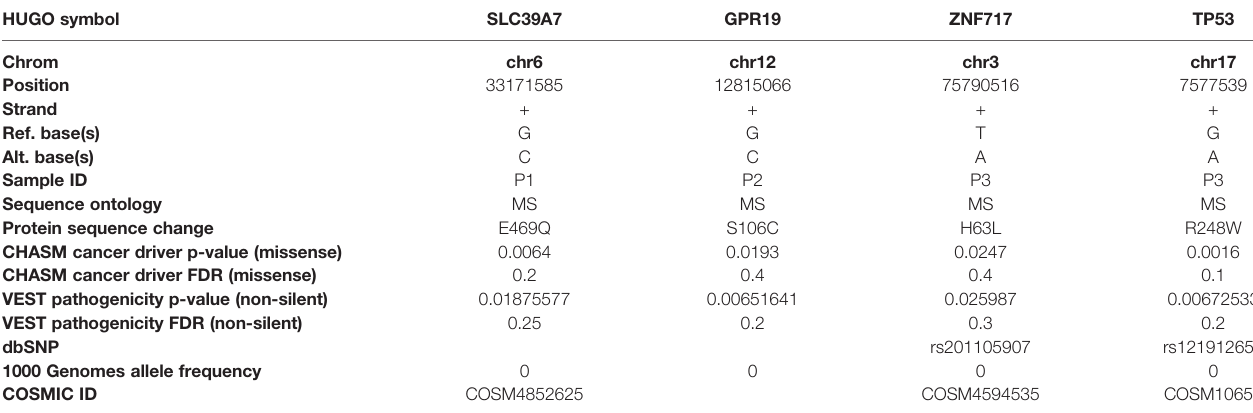
And the P-values of CHASM (Cancer-speci fi c High-throughput Annotation of Somatic Mutations) and VEST (Variant Effect Scoring Tool) were both set at < 0.05.